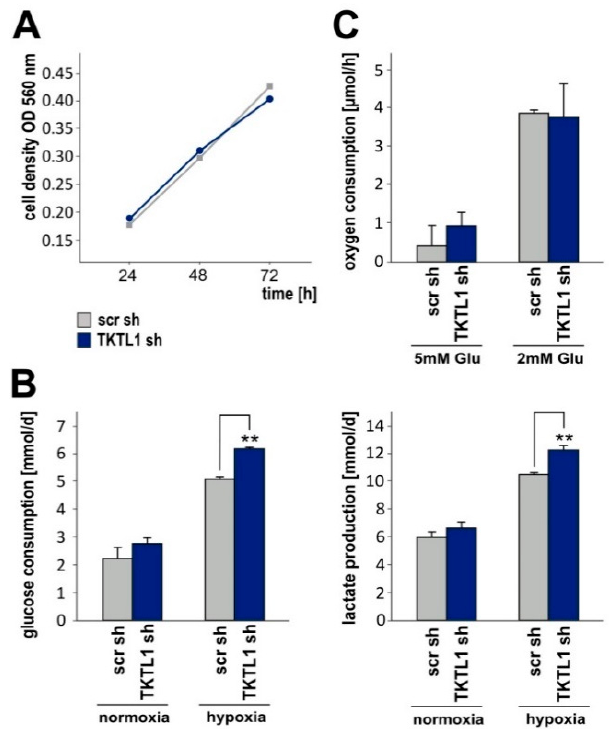
Figure 3. TKTL1 knockdown enhances glucose consumption and lactate production under hypoxic conditions. ( A ) LNT-229-shTKTL1 and control (scr) cells were cultured in normoxia. Cell density was assessed by crystal violet staining after 24 h, 48 h and 72 h; ( B ) cells were seeded in medium supplemented with 10% FCS and 25 mM glucose and 24 h later exposed to serum-free medium containing 6.5 mM glucose and normoxia or hypoxia. Another 24 h later, glucose and lactate in supernatants were measured (mean + SD, ** p < 0.01); ( C ) oxygen consumption was calculated by incubating the cells in serum-free medium containing 2 mM or 5 mM glucose for 8 h and using the OxoDish R system (mean + SD). 2.4. TKTL1 Knockdown Enhances Intracellular ROS Levels and Augments Cell Death during Oxygen Restriction